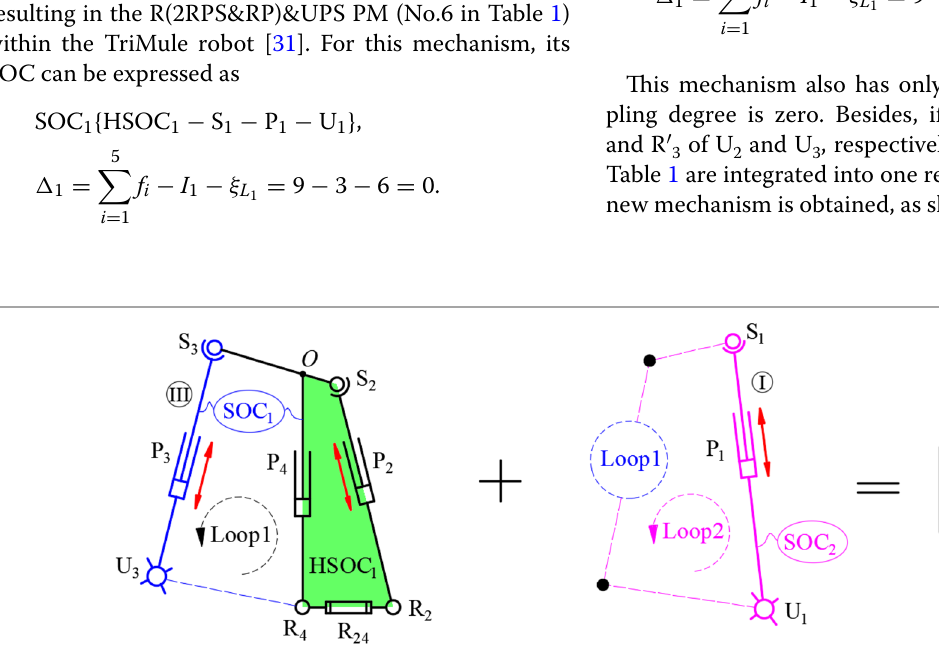
Figure 7 Topological decomposition of No.5